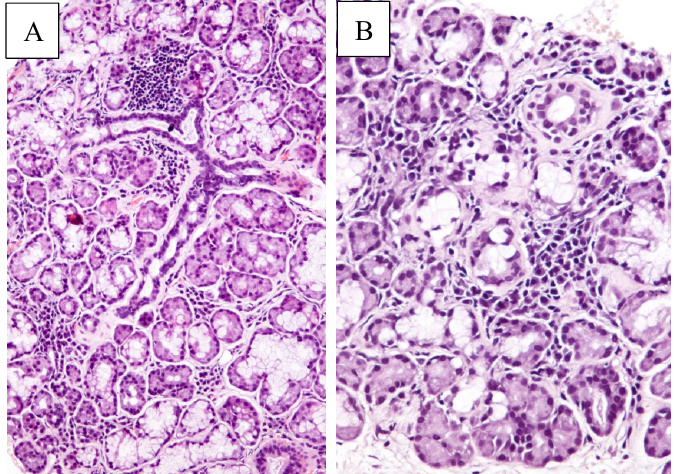
Figure 1. Low power magnification of minor salivary gland biopsy (( A ): hematoxylin and eosin, original magnification X100); at higher magnification, small lymphocyte and plasma cell aggregates (i.e., more than one lymphocytic focus) associated with mildly collagenized stroma are detectable (( B ): hematoxylin and eosin, original magnification X200).